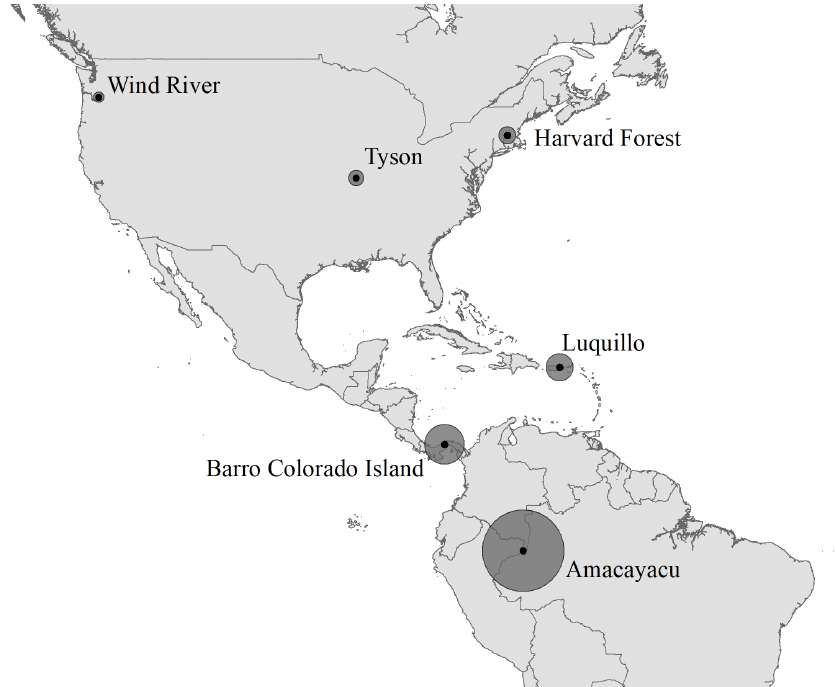
Figure 1. The geographic distribution of the six ForestGEO study sites we assessed for foundation species and their effects on diversity of associated woody plants. The size of the symbols are proportional to species richness of living woody species at each site: Wind River (20 species), Tyson (42), Harvard Forest (51), Luquillo (135), Barro Colorado Island (297), and Amacayacu (1232).